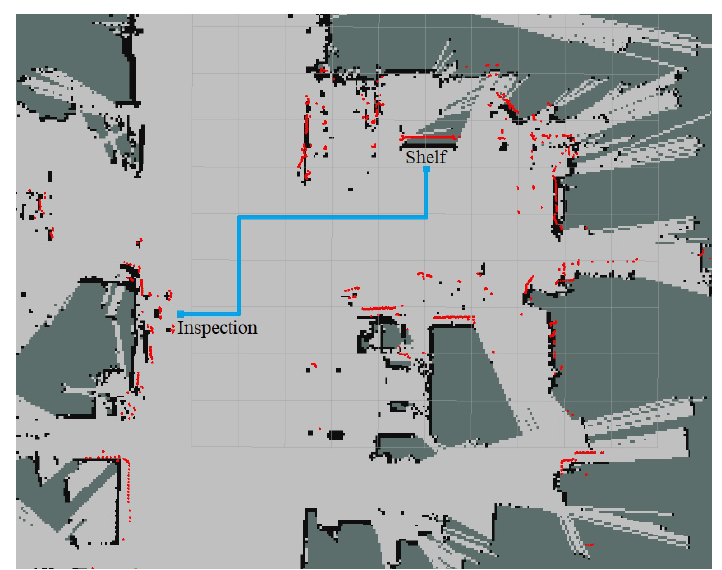
Figure 6. Co-manipulation path on workshop